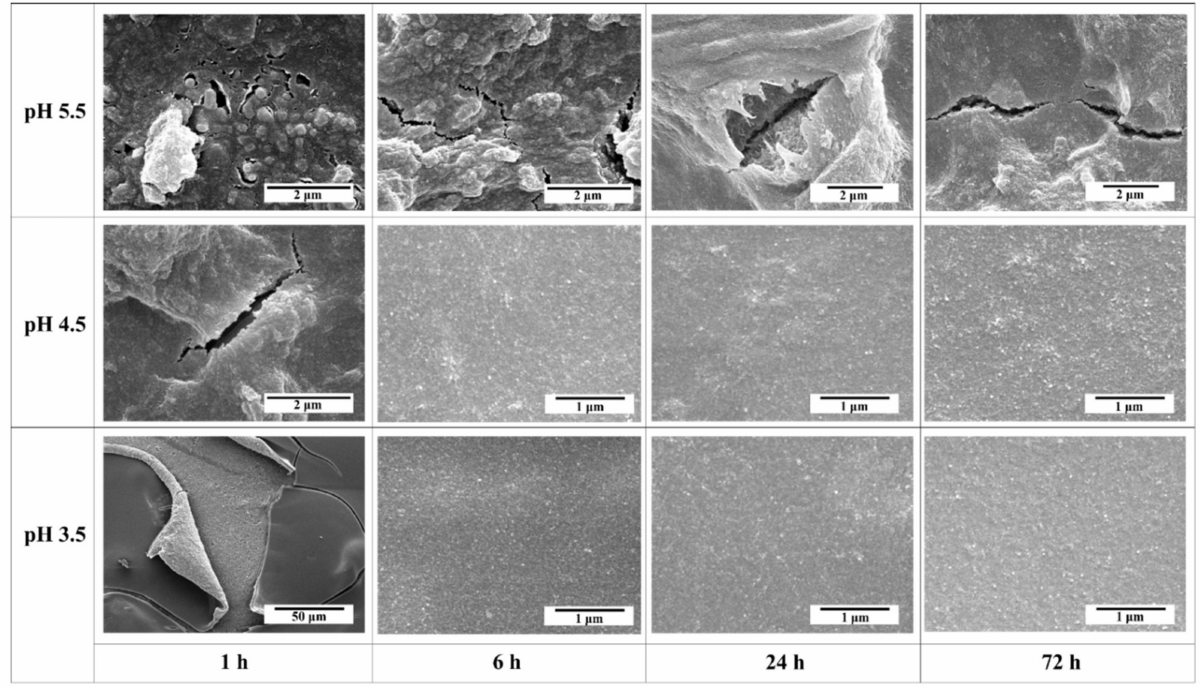
Figure 2. Effect of the different pH and peptization times on the appearance and stability of the Al 2 O 3 membranes after calcination at 600 ◦